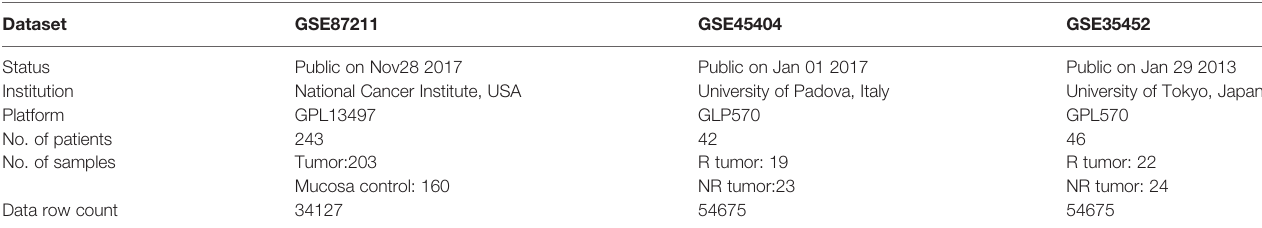
TABLE 1 | Characteristics of three datasets. Dataset